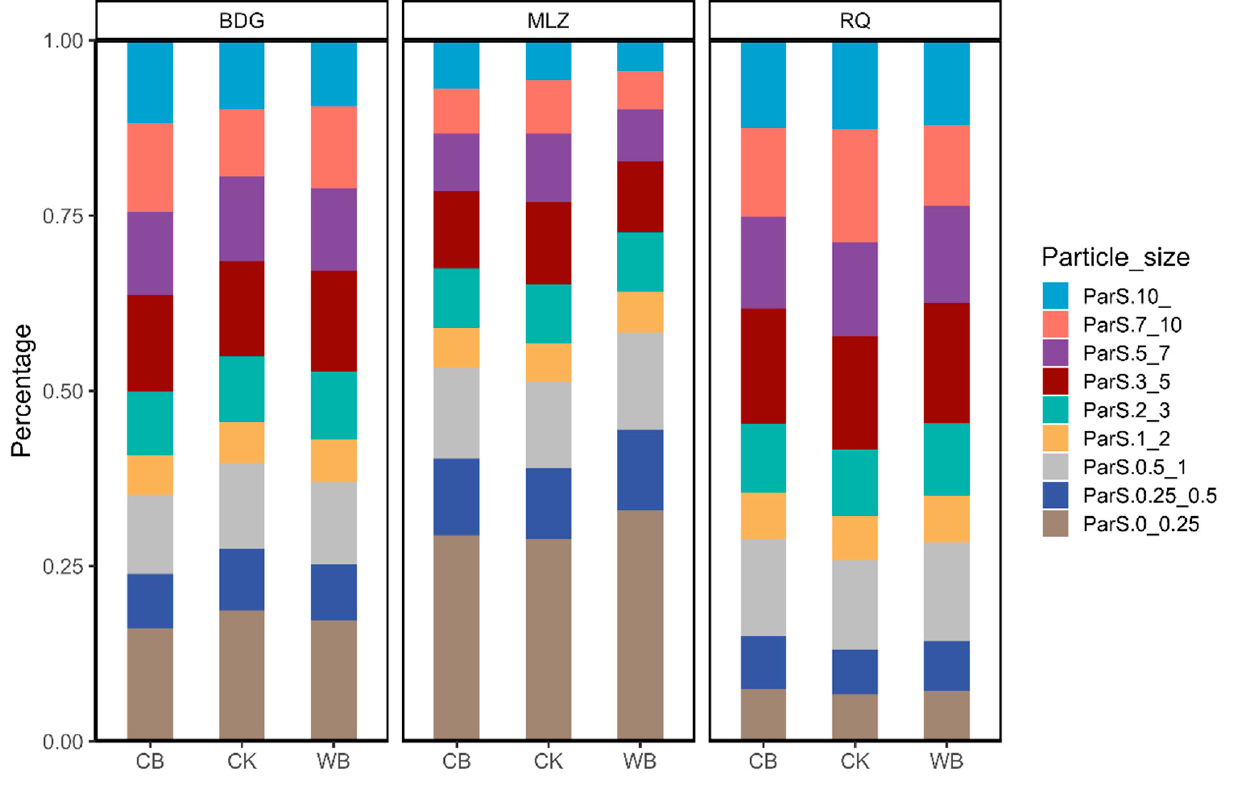
Figure 4. The stackplot of aggregate size distribution in sandy clay loam (BDG and MLZ) and silty clay loam (RQ) soils.